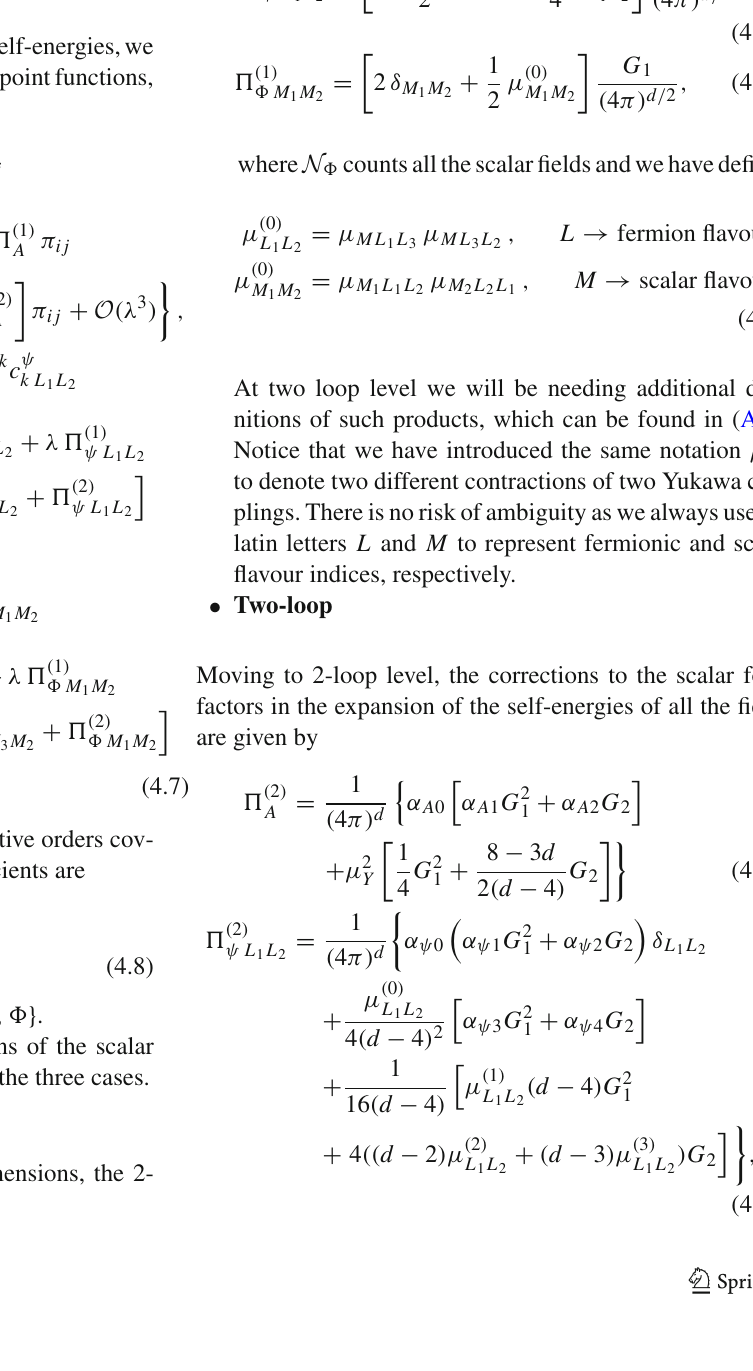
single and double trace quartic terms and the Yukawa cou- plings μ . Gauge invariance fixes the structure of the gauge self-energy as (cid:17) Aij = π ij (cid:17) A where the tensor π ij is